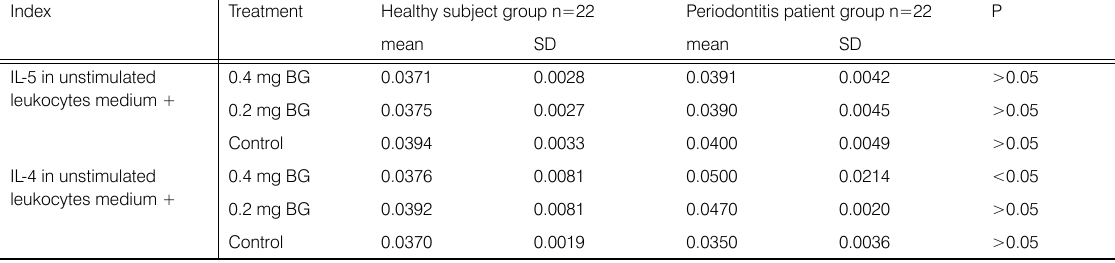
Table 5. IL-5 and IL-4 levels in unstimulated leukocytes medium and treated with ß -1,3/1,6-glucan.